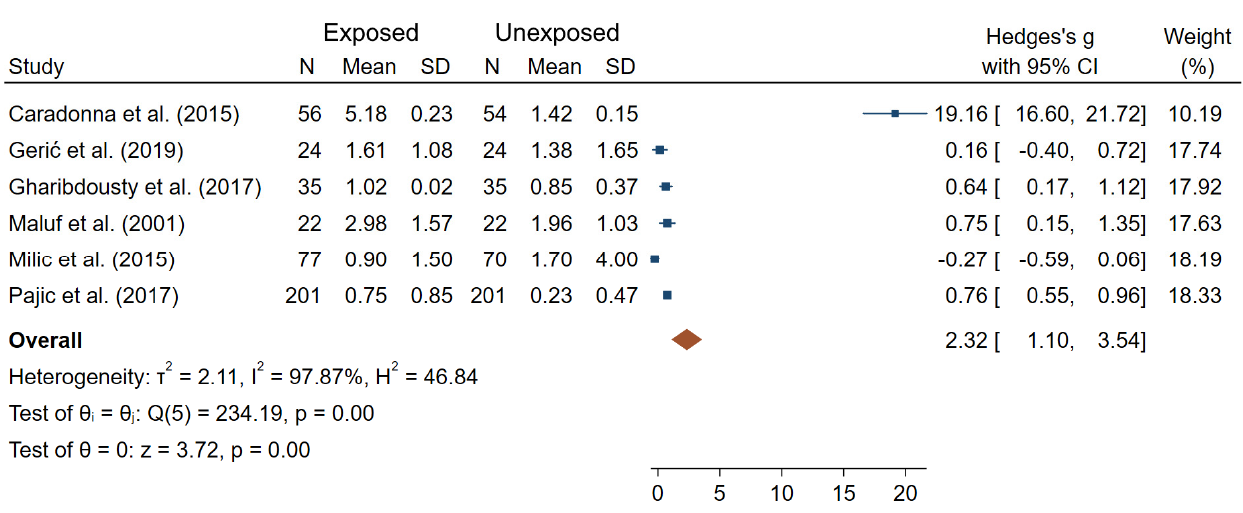
Figure 6. Forest plot of mean differences in NPB frequencies between IR exposed and unexposed workers.